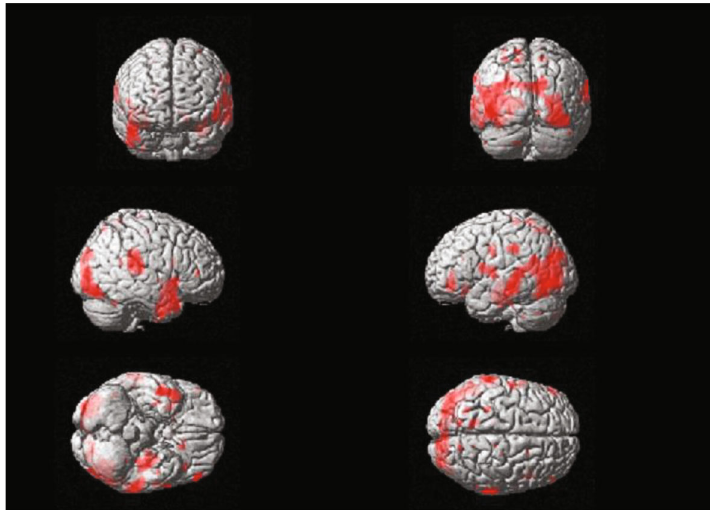
Figure 3: Brain activation image of clenching task at initial